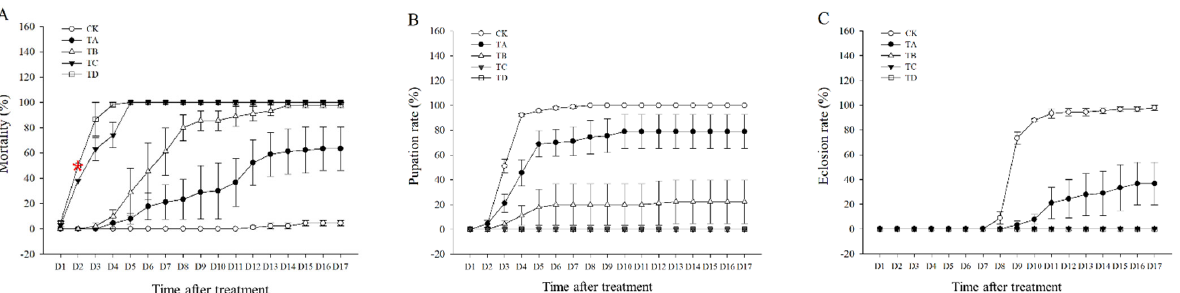
Figure 1. ( A ) Mortality rate, ( B ) pupation rate, and ( C ) eclosion rate of T. castaneum treated with different concentrations of carbon dioxide, represented by CK, TA, TB, TC, and TD. CK, treated with air; TA, treated with 25% CO 2 +75% air; TB, treated with 50% CO 2 +50% air; TC, treated with 75% CO 2 +25% air; TD, treated with 95% CO 2 +5% air. The same is true below. Pupation rate = (pupae number /eighth ‐ instar larval number) × 100%. Eclosion rate = (number of adults/pupal number) × 100%. Red * represented the time of 50% mortality rate in 95% CO 2 .